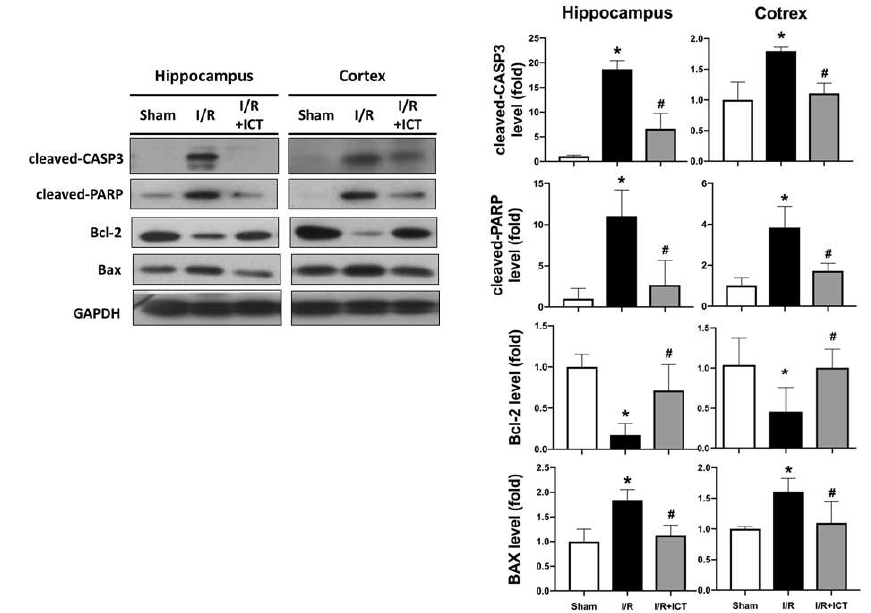
Figure 4. Effects of ICT treatment on the levels of protein expression of apoptotic markers in the left cerebral hemisphere of mice with acute cerebral ischemia-reperfusion. The levels of protein expression of apoptotic markers (cleaved caspase-3, cleaved PARP, Bcl-2, and Bax) in the hippocampus and cortex areas were determined by Western blotting. Protein expression was quantified by densitometry. Data are presented as mean ± SD (n ≥ 4). * p < 0.05 compared to sham group; # p < 0.05 compared to I/R group.